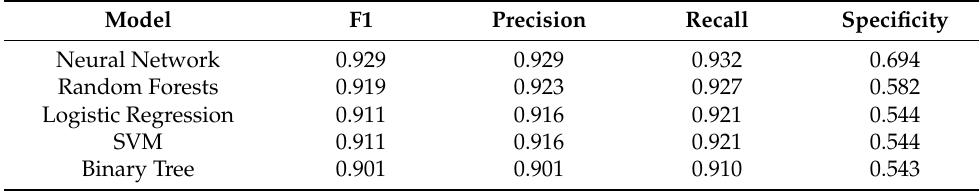
Table 8. Models accuracy metrics average over classes with add_to_cart_both as target parameter.